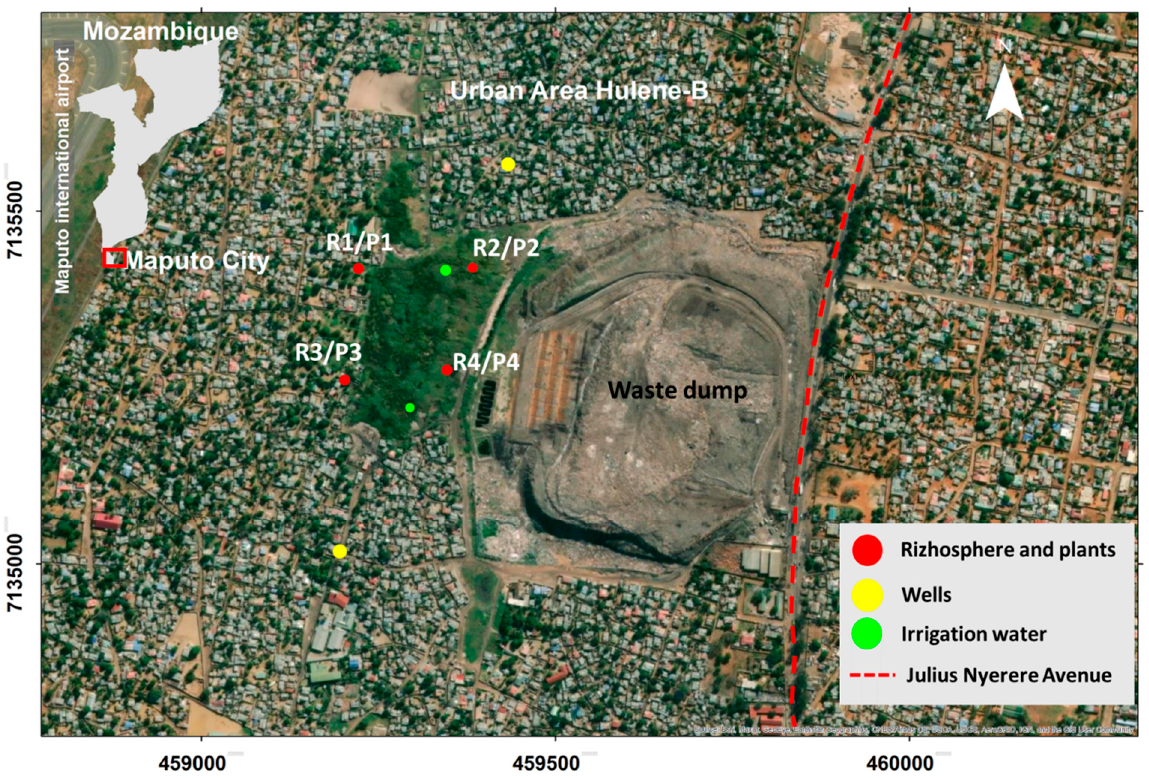
Figure 1. Sampling locations, and surrounding environment, with numerous dwellings surrounding Hulene-B waste dump (center), airport (NW), and Julius Nyerere Avenue (E).